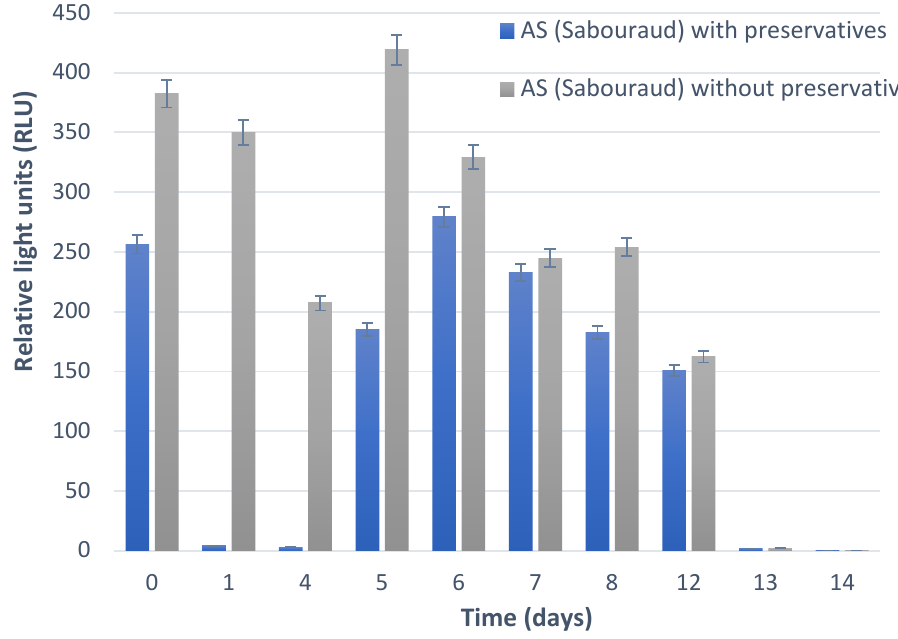
Figure 3. RLU mean values of aubergine salad (AS) with and without preservatives in relation to storage time, after incubation in Sabouraud liquid medium for 24 h at 35 °C.